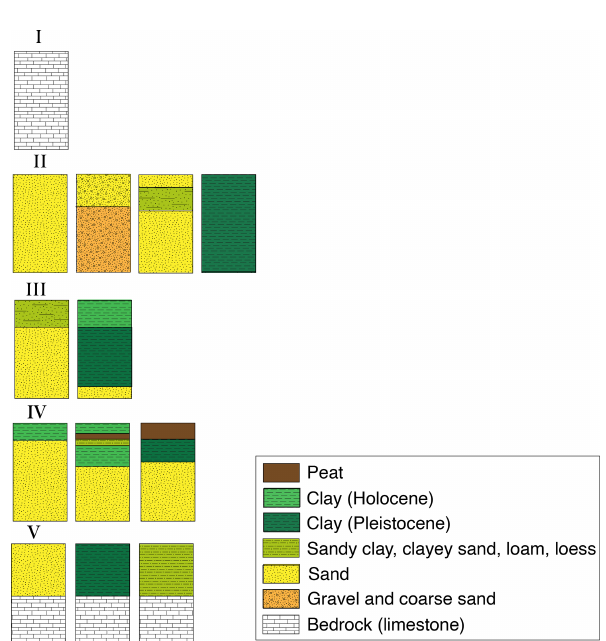
Figure 9. Sediment profiles corresponding to the classification pre- sented in Table 1, where the different columns are typical examples of the top 50m of the Netherlands. The division in classes is based on the shallow subsurface composition related to the expected level of wave amplification during a seismic